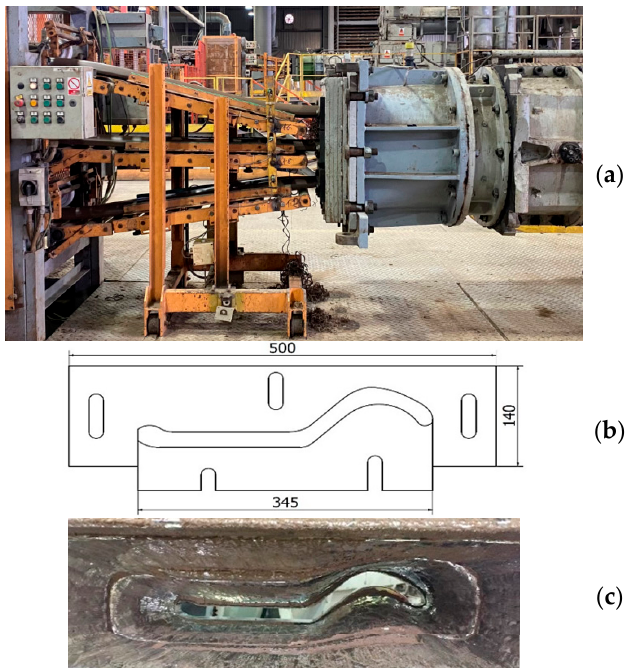
Figure 2. The process of extruding the clay band onto the ceramic tiles: ( a ) main view of the machines; ( b ) CAD drawing of a single set of tools with approximate dimensions; ( c ) photo of the worn chamber (mouthpiece).